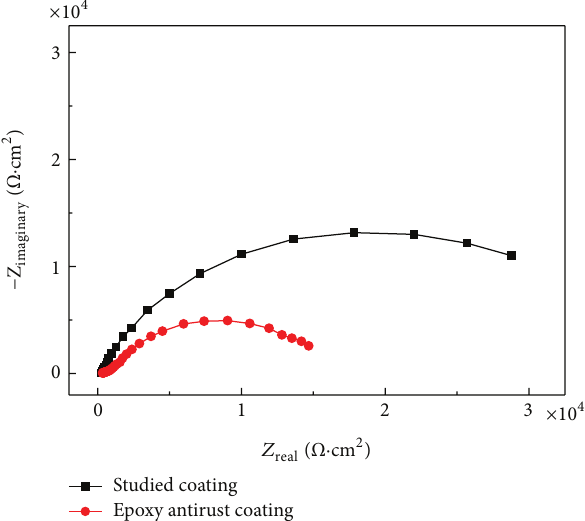
Figure 5: Impedance spectra of epoxy antirust painted samples and painted samples with scratch after 8-day immersion times in 3.5 wt% NaCl solution.